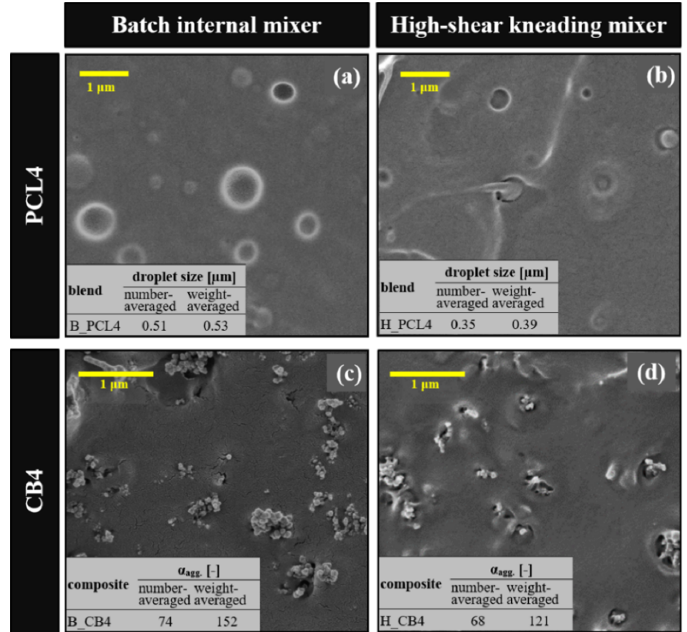
Figure 2. SEM images of the fractured surface of ( a , b ) PLA/PCL blends (PCL4) and ( c , d ) 4 wt.% CB/PLA binary composites (CB4) prepared by batch mixing and high-shear kneading processing.